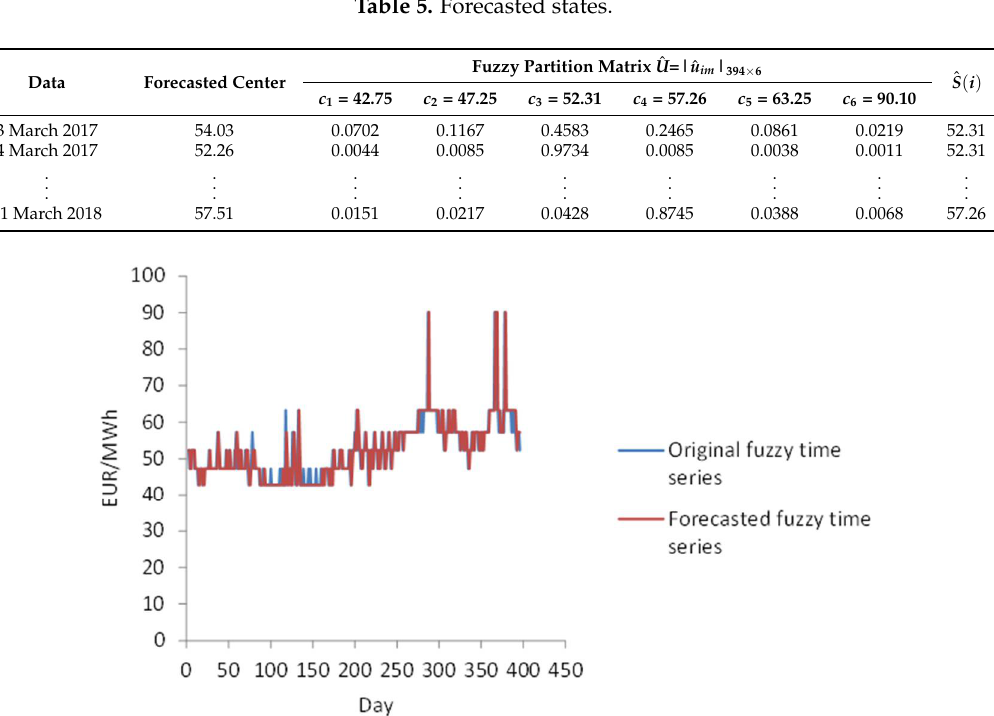
| 47.25 − 52.31 | × 100 = |(cid:2872)(cid:2875).(cid:2870)(cid:2873)(cid:2879)(cid:2873)(cid:2870).(cid:2871)(cid:2869)| 47.25 × 100 = 10.71% . Mean (cid:2872)(cid:2875).(cid:2870)(cid:2873)